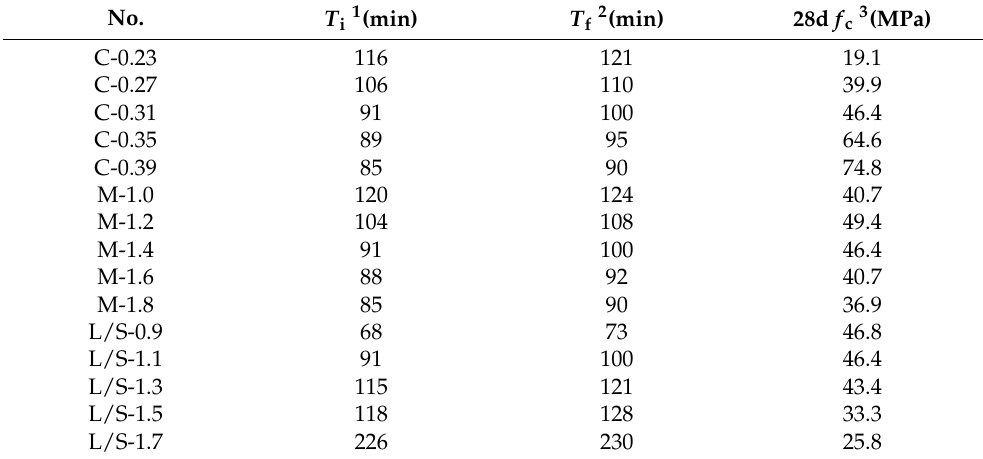
Table 5. Setting time and compressive strength of MK/GGBFS-blended geopolymer pastes.